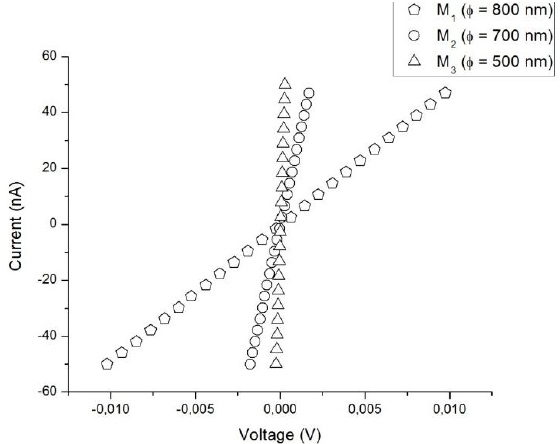
Figure 2. I–V characteristics of single ZnO nanowire devices showing an ohmic